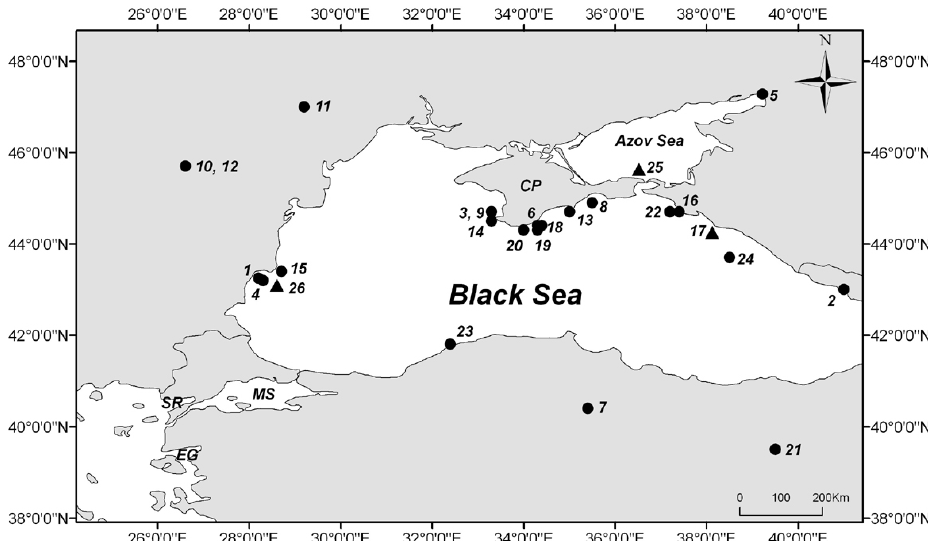
Fig. 1. Sources of tsunami generation in the Black Sea and the Azov Sea (for data see Table 1). Key: a solid circle is a seismic source, a solid triangle is a gravitative sliding source; CP=Caspian Peninsula, EG=Edremit Gulf, MS=Marmara Sea, SR=Saros